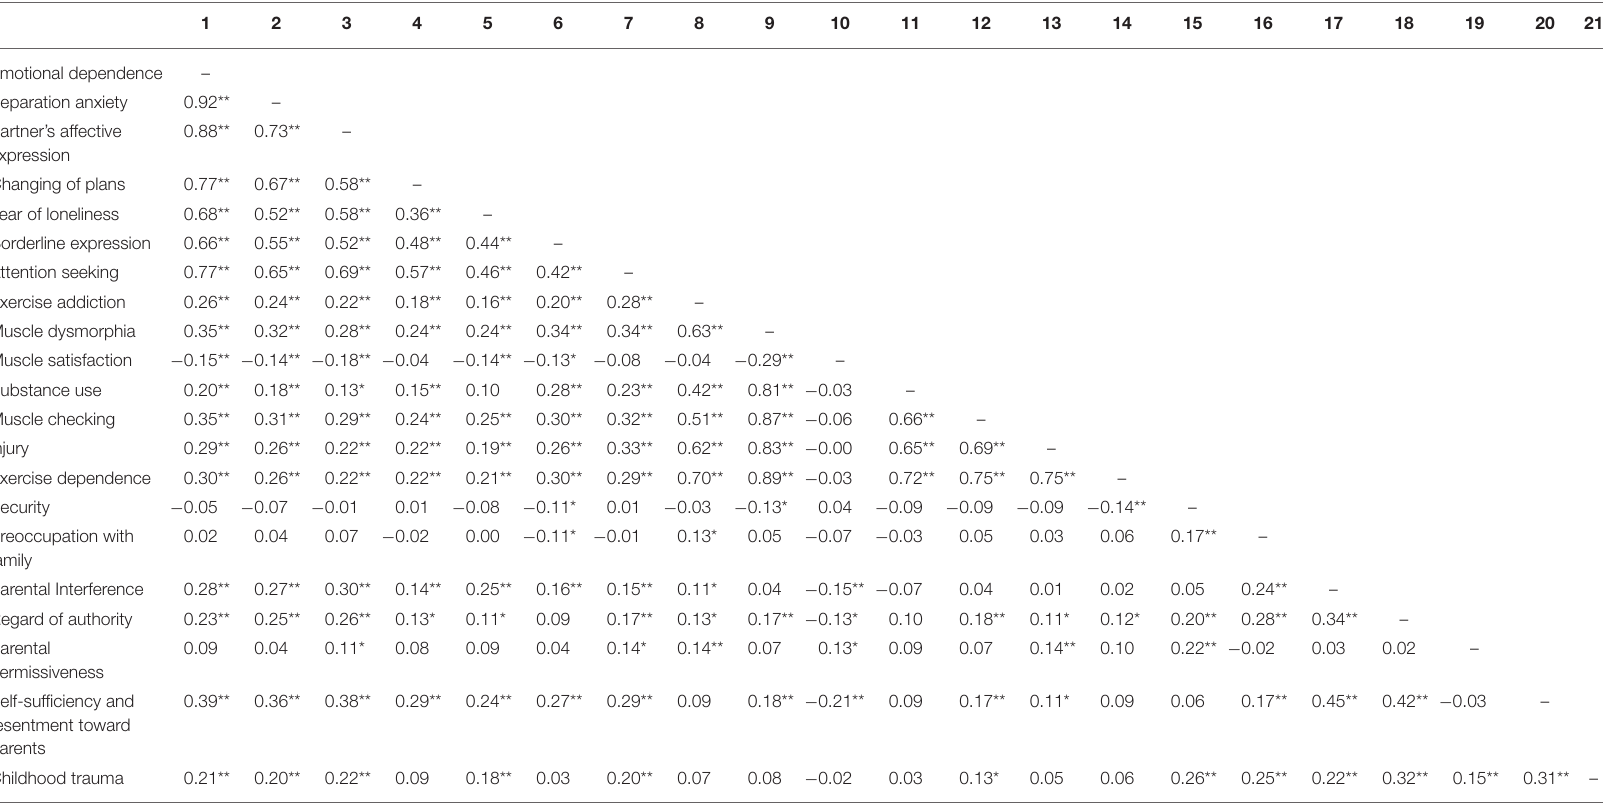
TABLE 3 | Correlations between emotional dependence, exercise addiction, muscle dysmorphia, and